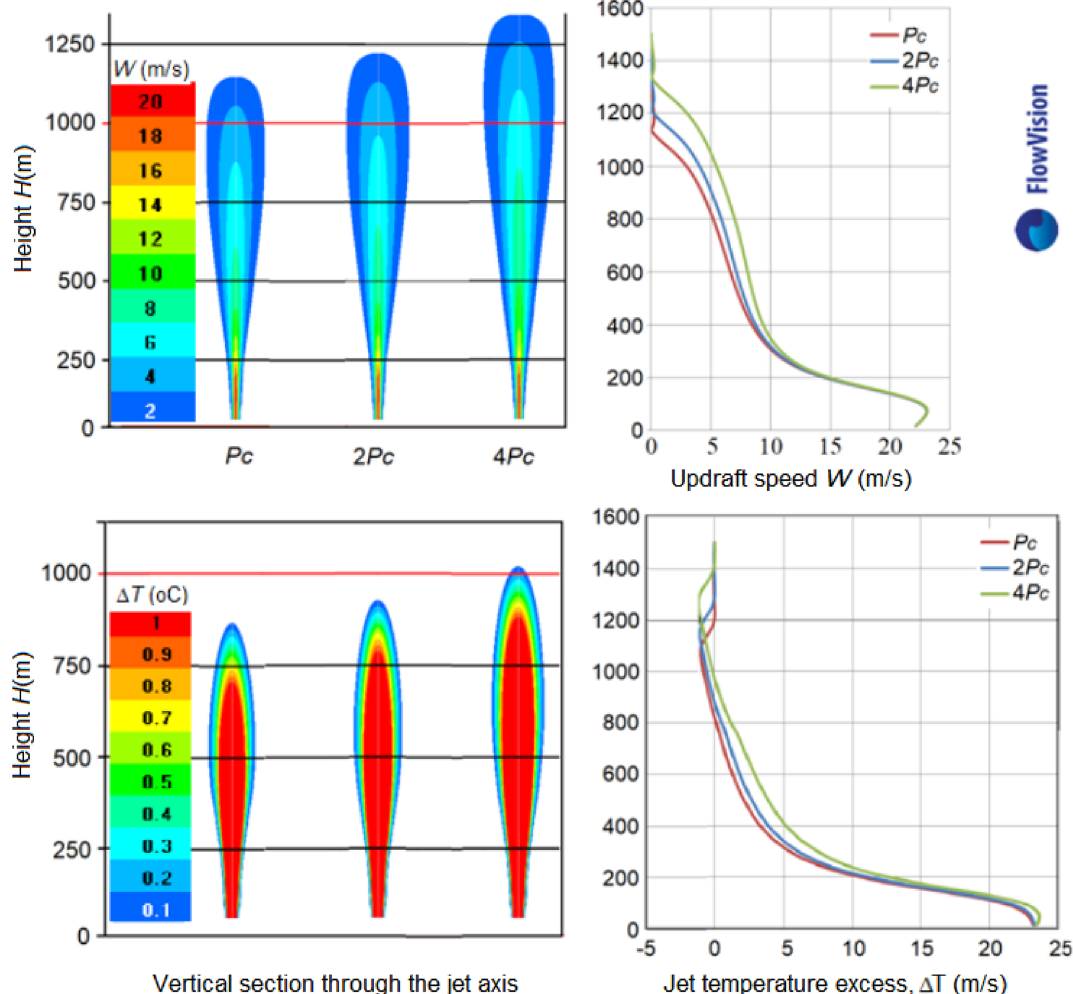
Figure 15. Vertical sections of W and Δ T at jet feeding P C , 2 P C and 4 P C in a windless atmosphere and γ = 6.5